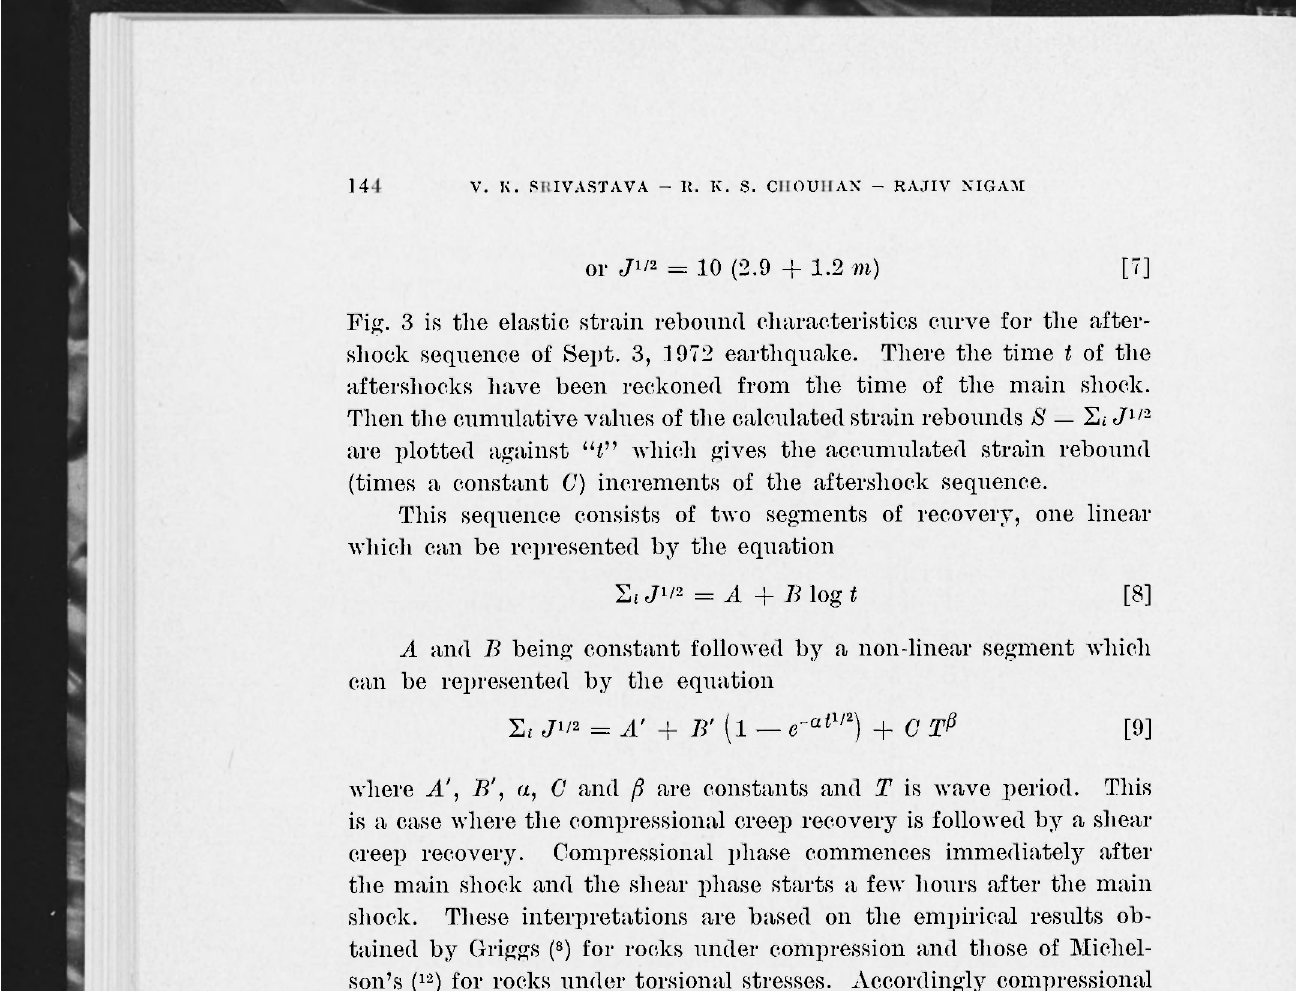
Fig. 3 is the elastic strain rebound characteristics curve for the after- shock sequence of Sept. 3, 1972